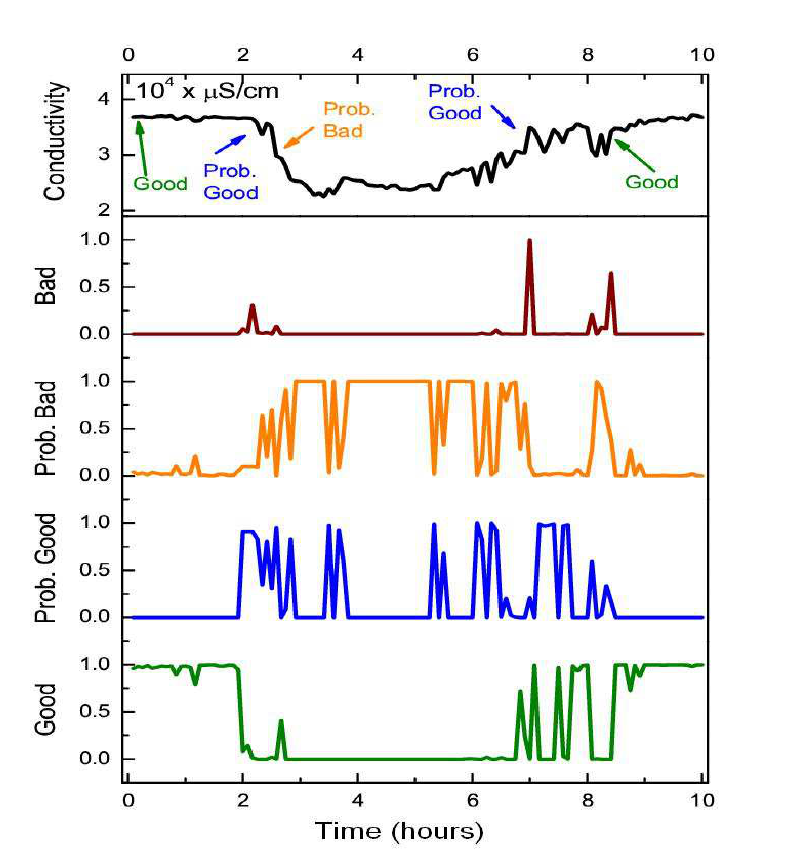
Figure 8. The top time-series of each figure corresponds to a section of sensor readings from the conductivity sensor at 1 m that have been assessed by a human expert and automatically flagged by the static BN. The four bottom series correspond to the posterior probabilities of the (between 0–1) quality states of each sensor sample in the network. The arrows upon the top time-series correspond to the points at which the expert’s assessment has changed to the quality state